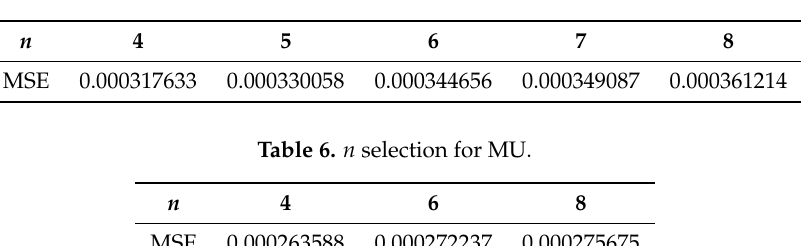
Table 5. n Selection for FB.